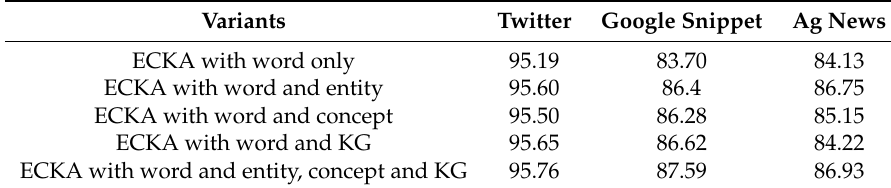
Table 5. The text classification comparison of ECKA